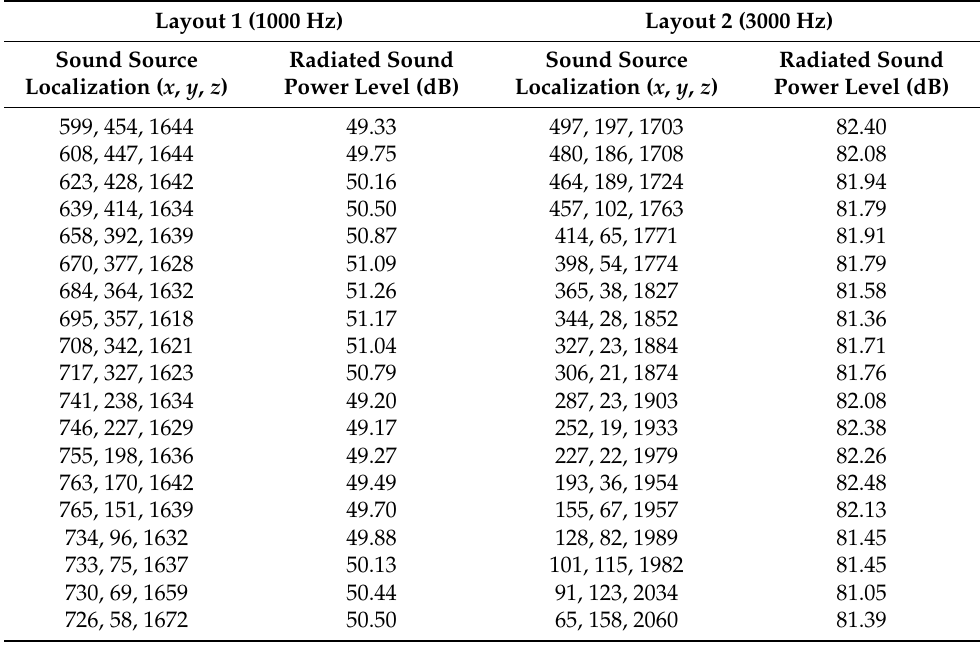
Figure 8. Sound source localization results of layout 2 (3000 Hz) in the experiment. ( a ) Images of the Start position. ( b ) Images of the Middle position. ( c ) Images of the End position. Table 3. Sound power of the localized sound source at different